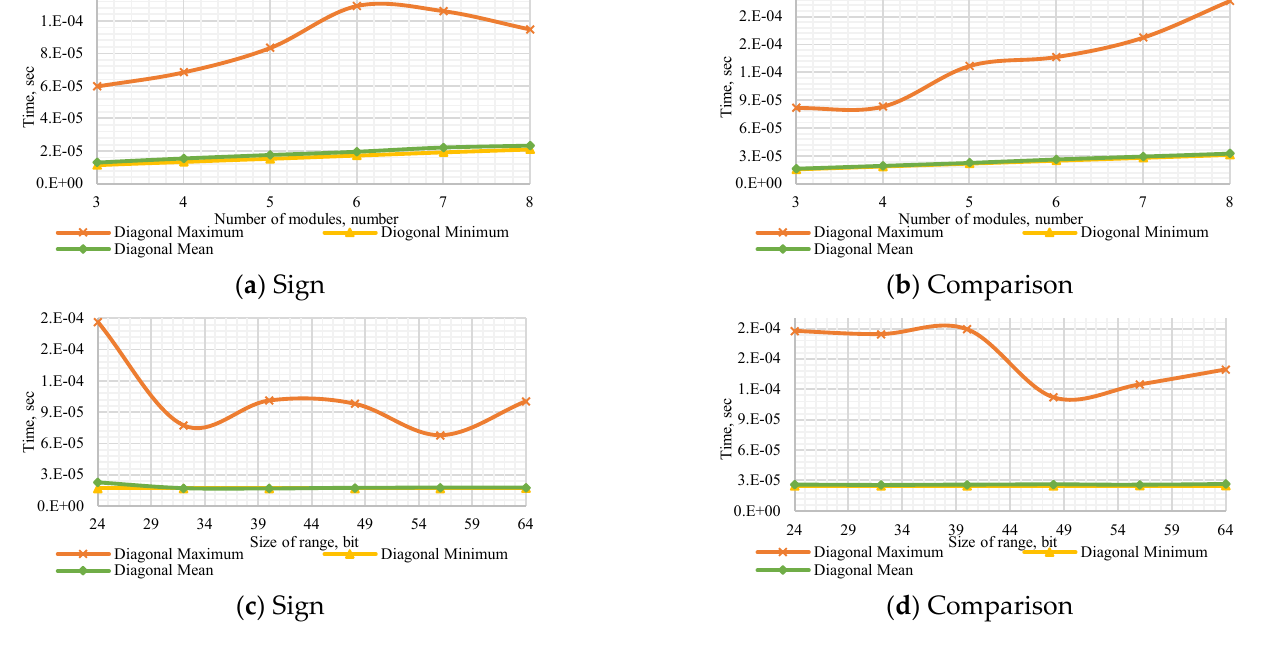
Figure A4. Performance of the Diagonal Method to ( a ) determine the number’s sign with a dynamic number of modules p , ( b ) compare dynamic numbers of modules p , ( c ) determine the number’s sign with a dynamic bit width, and ( d ) compare numbers with dynamic bit width.